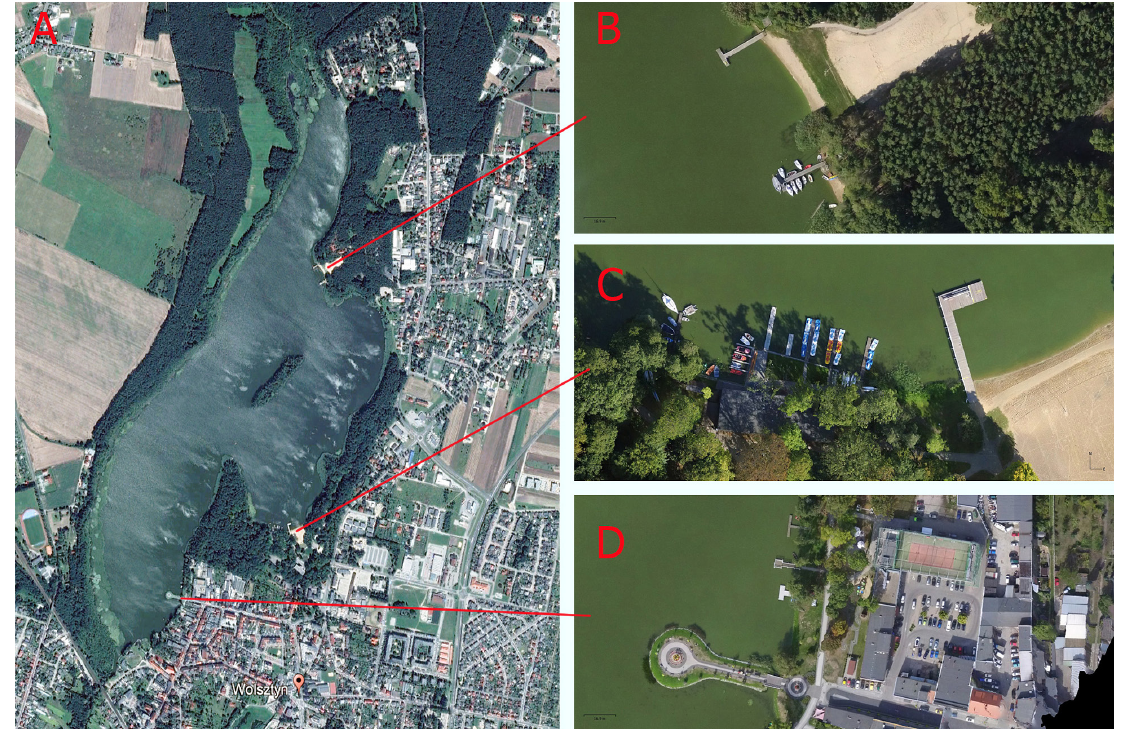
Fig. 5. Tourist and recreational infrastructure of Lake Wolsztyńskie.